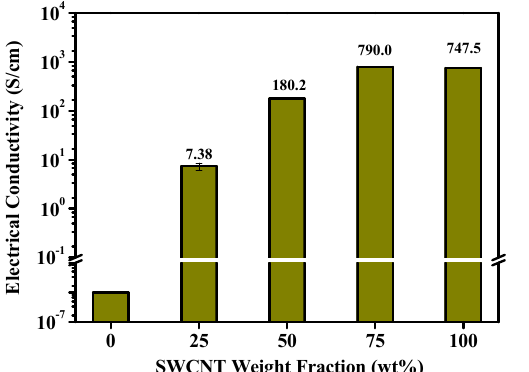
Figure 5. Electrical conductivity of SWCNT/ANF composite sheets according to SWCNT weight fraction.